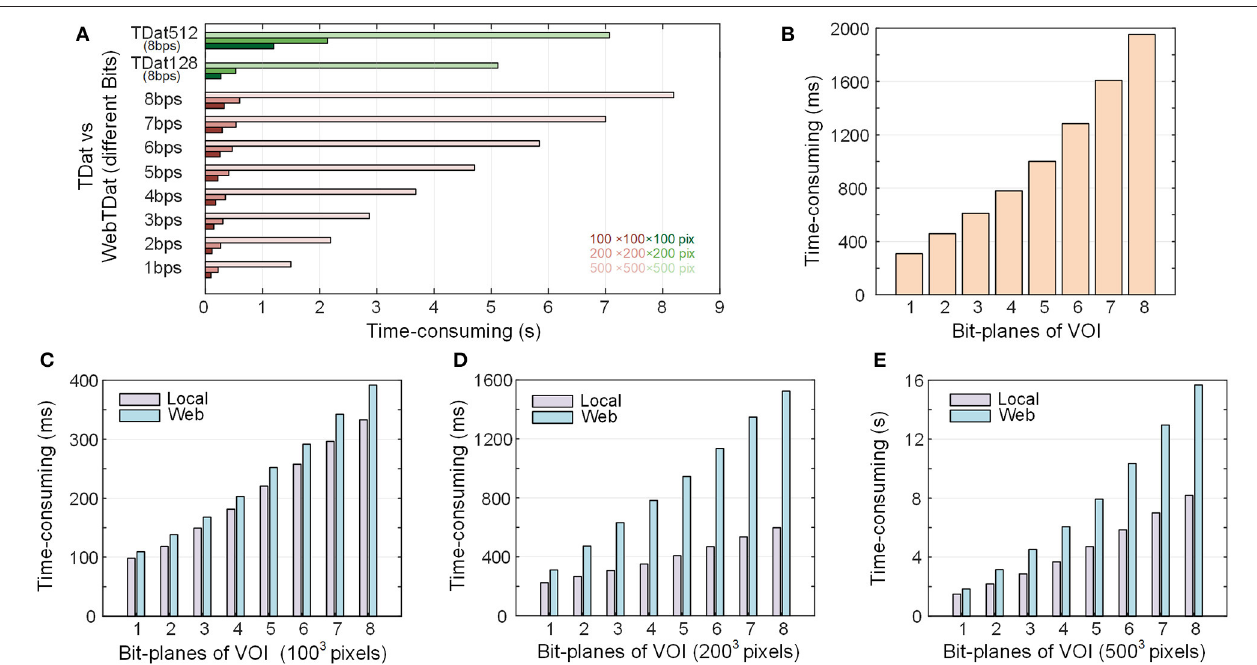
FIGURE 6 | Time consumption to render VOIs from the webTDat dataset: (A) Time consumption to render VOIs at three fixed sizes with webTDat compared to the time consumption required by the original TDat (TDat512) and TDat128. The webTDat results are displayed according to different bit depths. The different colors represent different ROI sizes. This benchmark was conducted in a stand-alone environment. (B) Time consumption to render VOIs of random size by webTDat. The results are displayed according to different bit depths. (C–E) Comparison of VOI rendering times between local and networked environments. The VOI sizes are 100 3 , 200 3 , and 500 3 pixels. All the benchmarks were repeated more than 20 times for each ROI size, and the average runtime was calculated. The numerical data can be found in the Supplementary Table